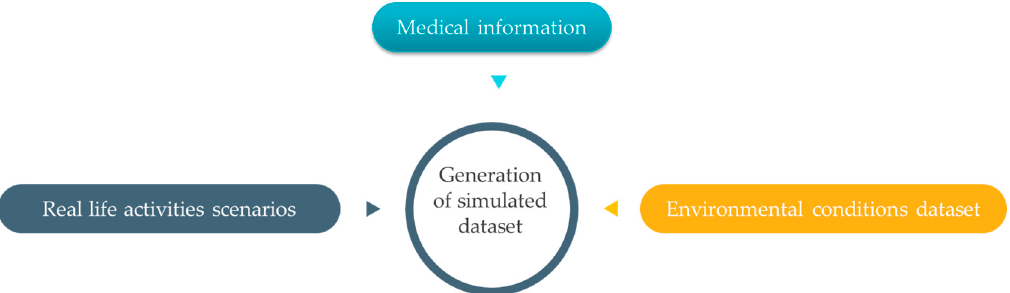
Figure 9. Dataset. Figure 9.